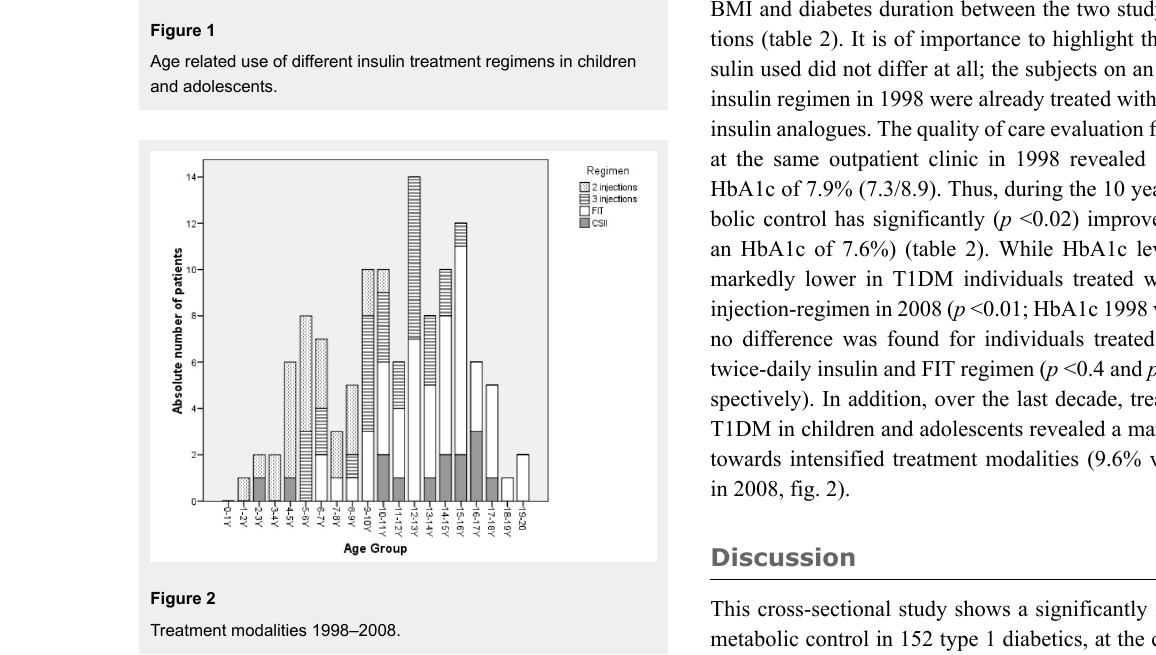
Treatment modalities 1998–2008.